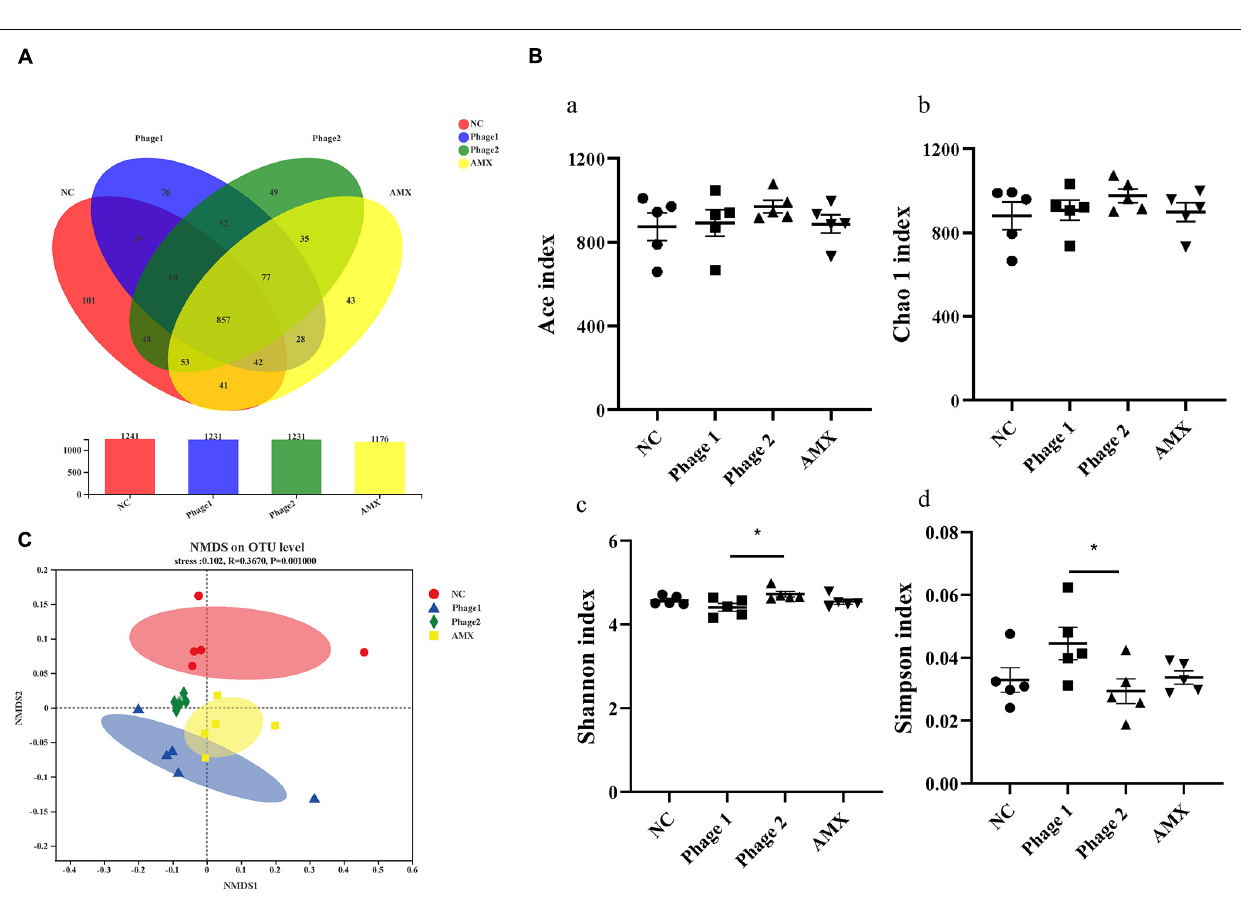
FIGURE 6 | Effect of phages on the cecal microbiota of chicks. (A) Venn diagram generated to compare operational taxonomic units (OTUs) between different groups. (B) Diversity and richness indexes of cecal microbiota in each group. Figure a-d represents ACE, Chao1, Shannon and Simpson indices, respectively. * p < 0.05. (C) Beta-diversity analysis of cecal microbiota among groups. NMDS analysis based on Bray–Curtis distances. Points of different colors or shapes represent samples of different groups. The closer the two sample points are, the more similar the species composition of the two samples. NC, negative control; Phage 1, 10 9 PFU GRNsp6 (day 3-5); Phage 2, 10 9 PFU GRNsp6 (day 8-10); AMX, 1 mg/ml amoxicillin (day